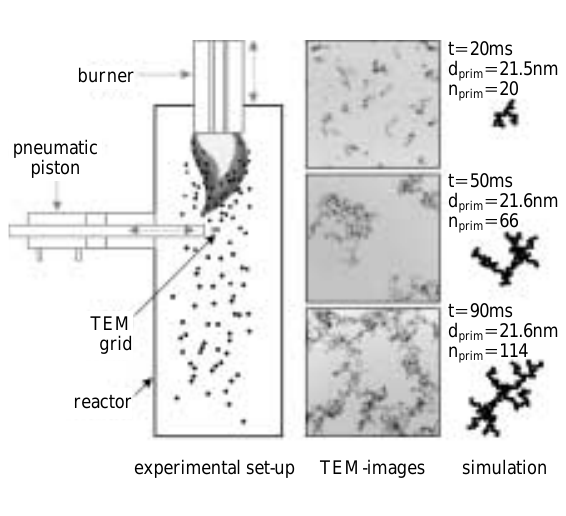
Schematic of the TEM-grid sampling system mounted to a flame reactor, sampled TEM images, and corresponding simulation